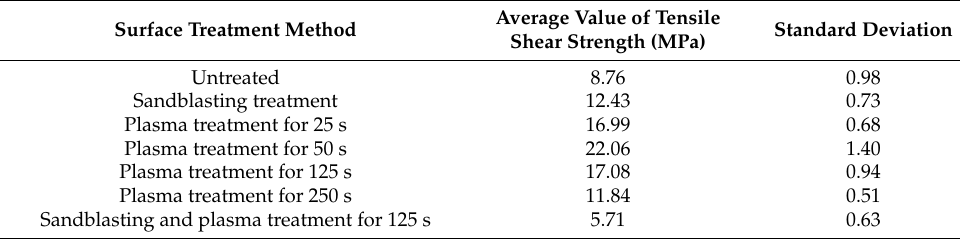
Table 6. Tensile shear strength of CF/EP single-lap joints with different surface